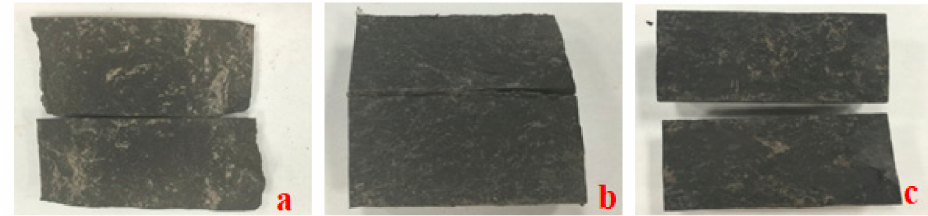
Figure 1. Fractures of shale samples. ( a ) Shale fracture 1; ( b ) Shale fracture 2; ( c ) Shale fracture 3.